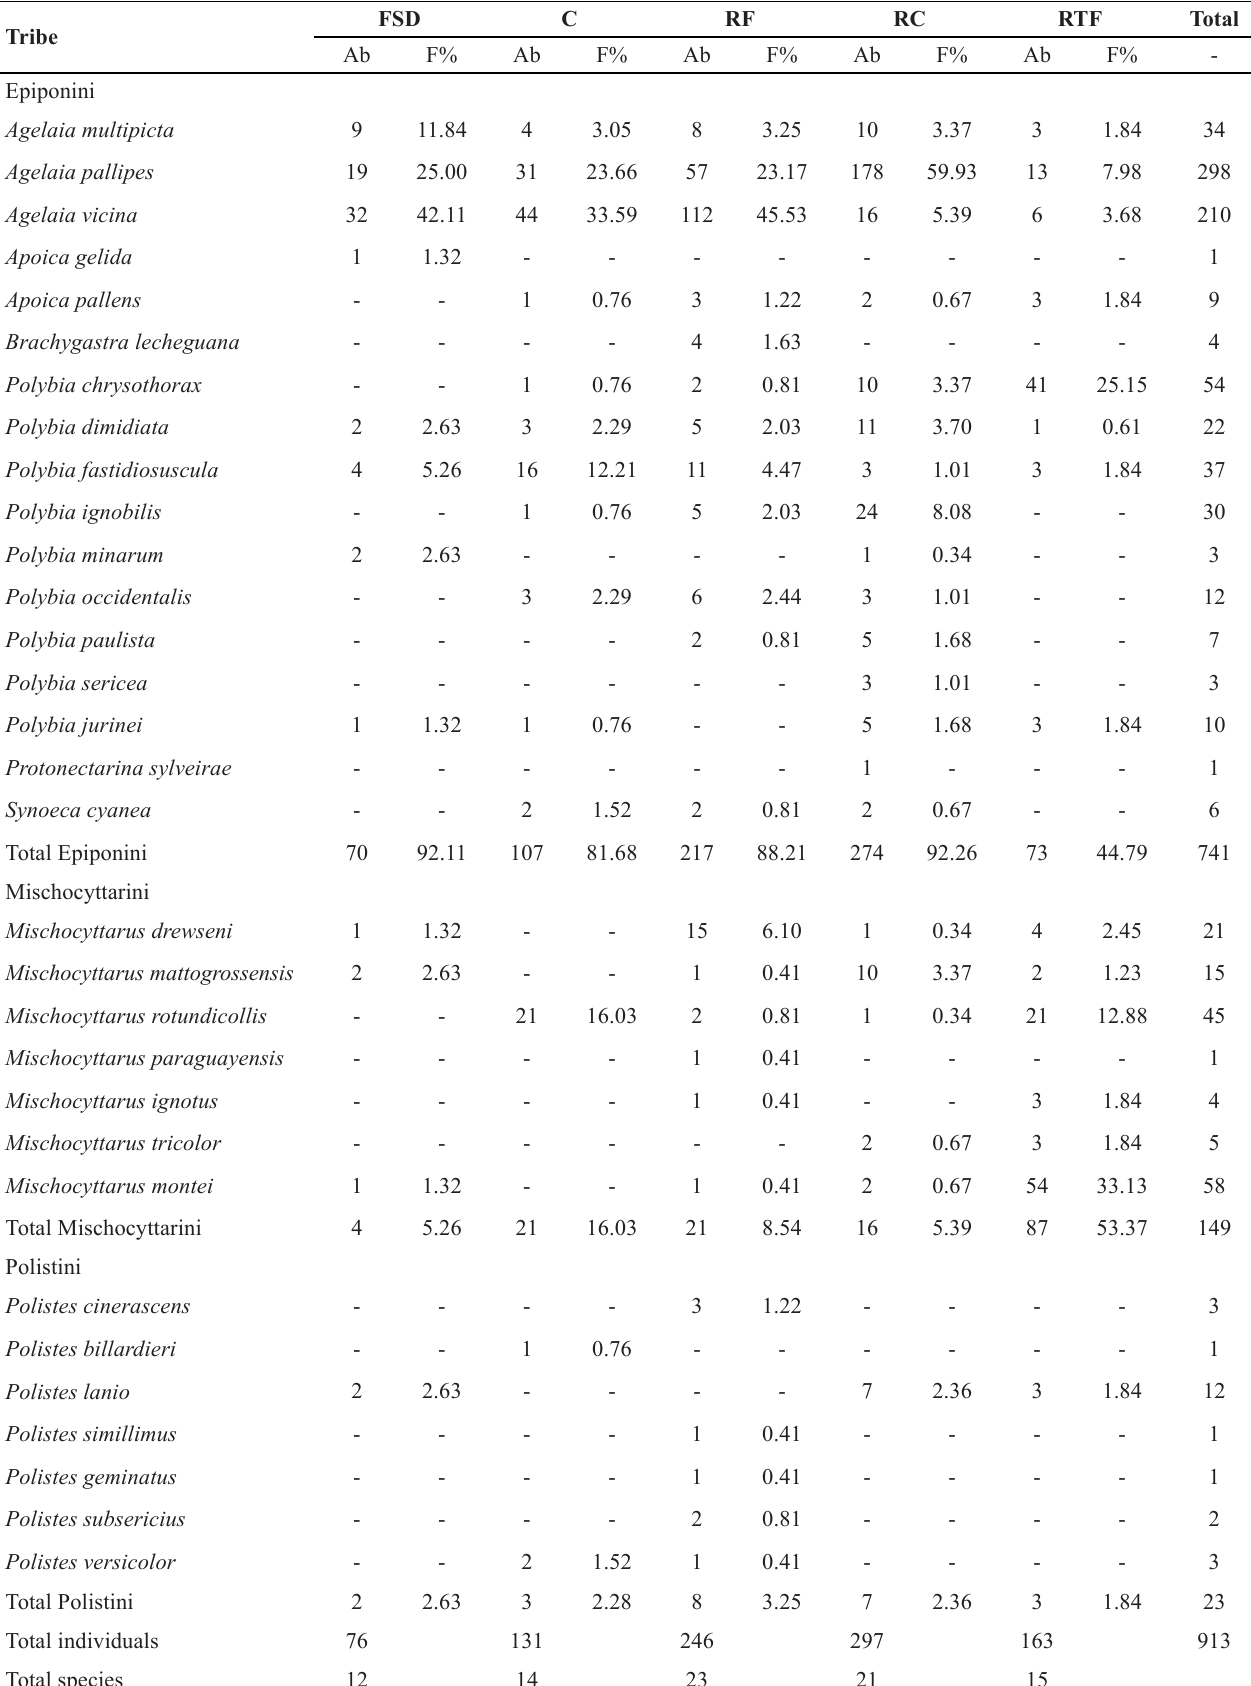
Table 2 . Abundance (Ab) and relative frequency (F%) of wasp species sampled in five study areas in east central São Paulo state. FSD: Semideciduous forest; C: Cerradão; RF: Riparian forest; RC: Regenerating Cerrado; RTF: Restored